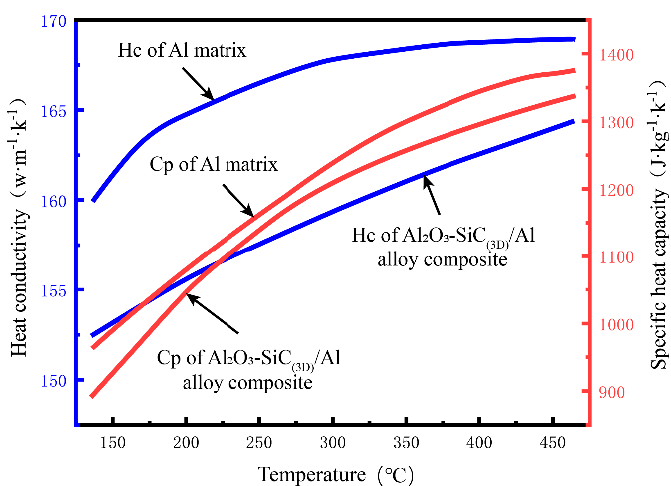
Figure 2. Heat conductivity and specific heat capacity of brake disc materials.